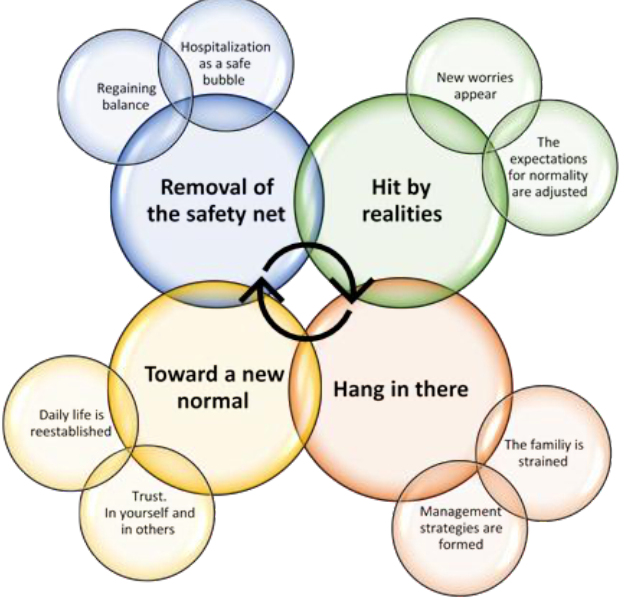
Figure 1. Overview of themes and subthemes identified in the interviews.